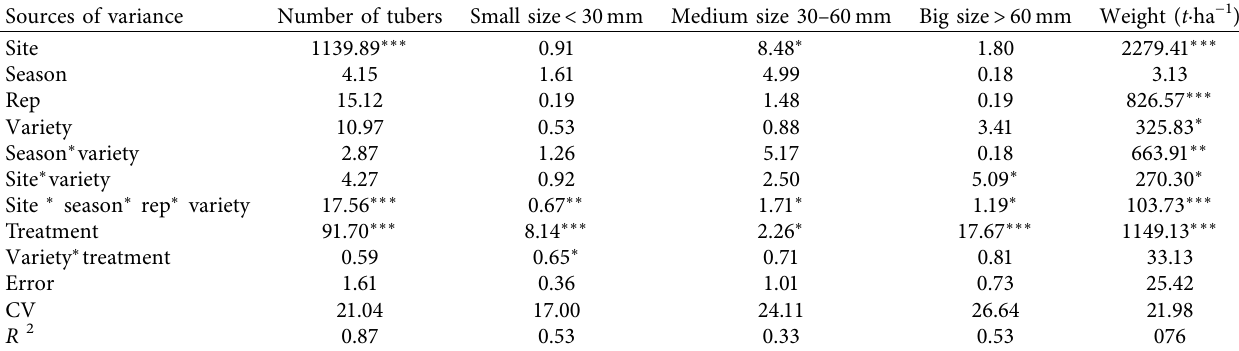
Table 11: The mean squares for tuber yield in Molo and Egerton in the 2019–2020 seasons.